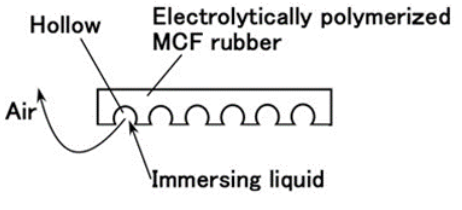
Figure 6. Physical model of infiltrated MCF rubber with a liquid.